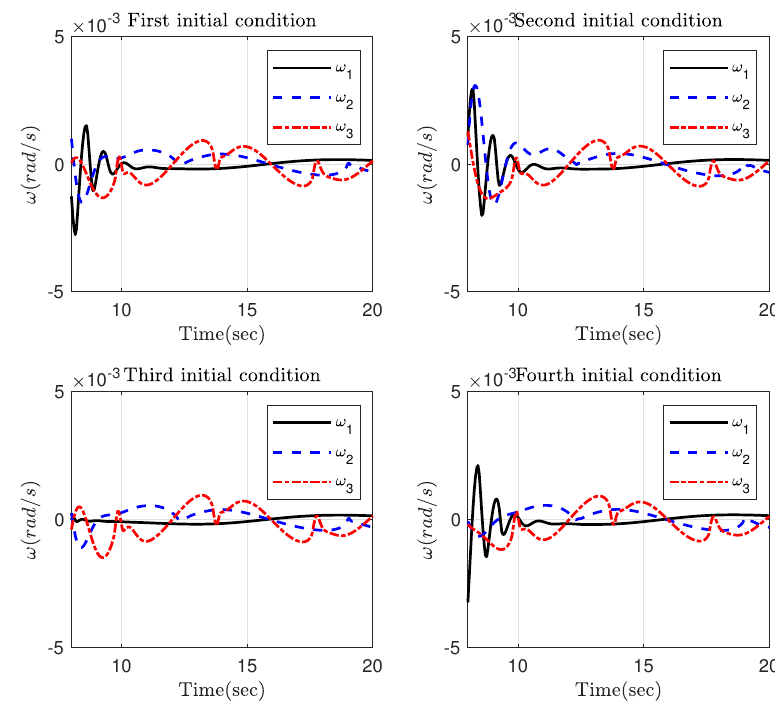
Figure 11. Steady state behavior of the control torque in Part 1 for different initial